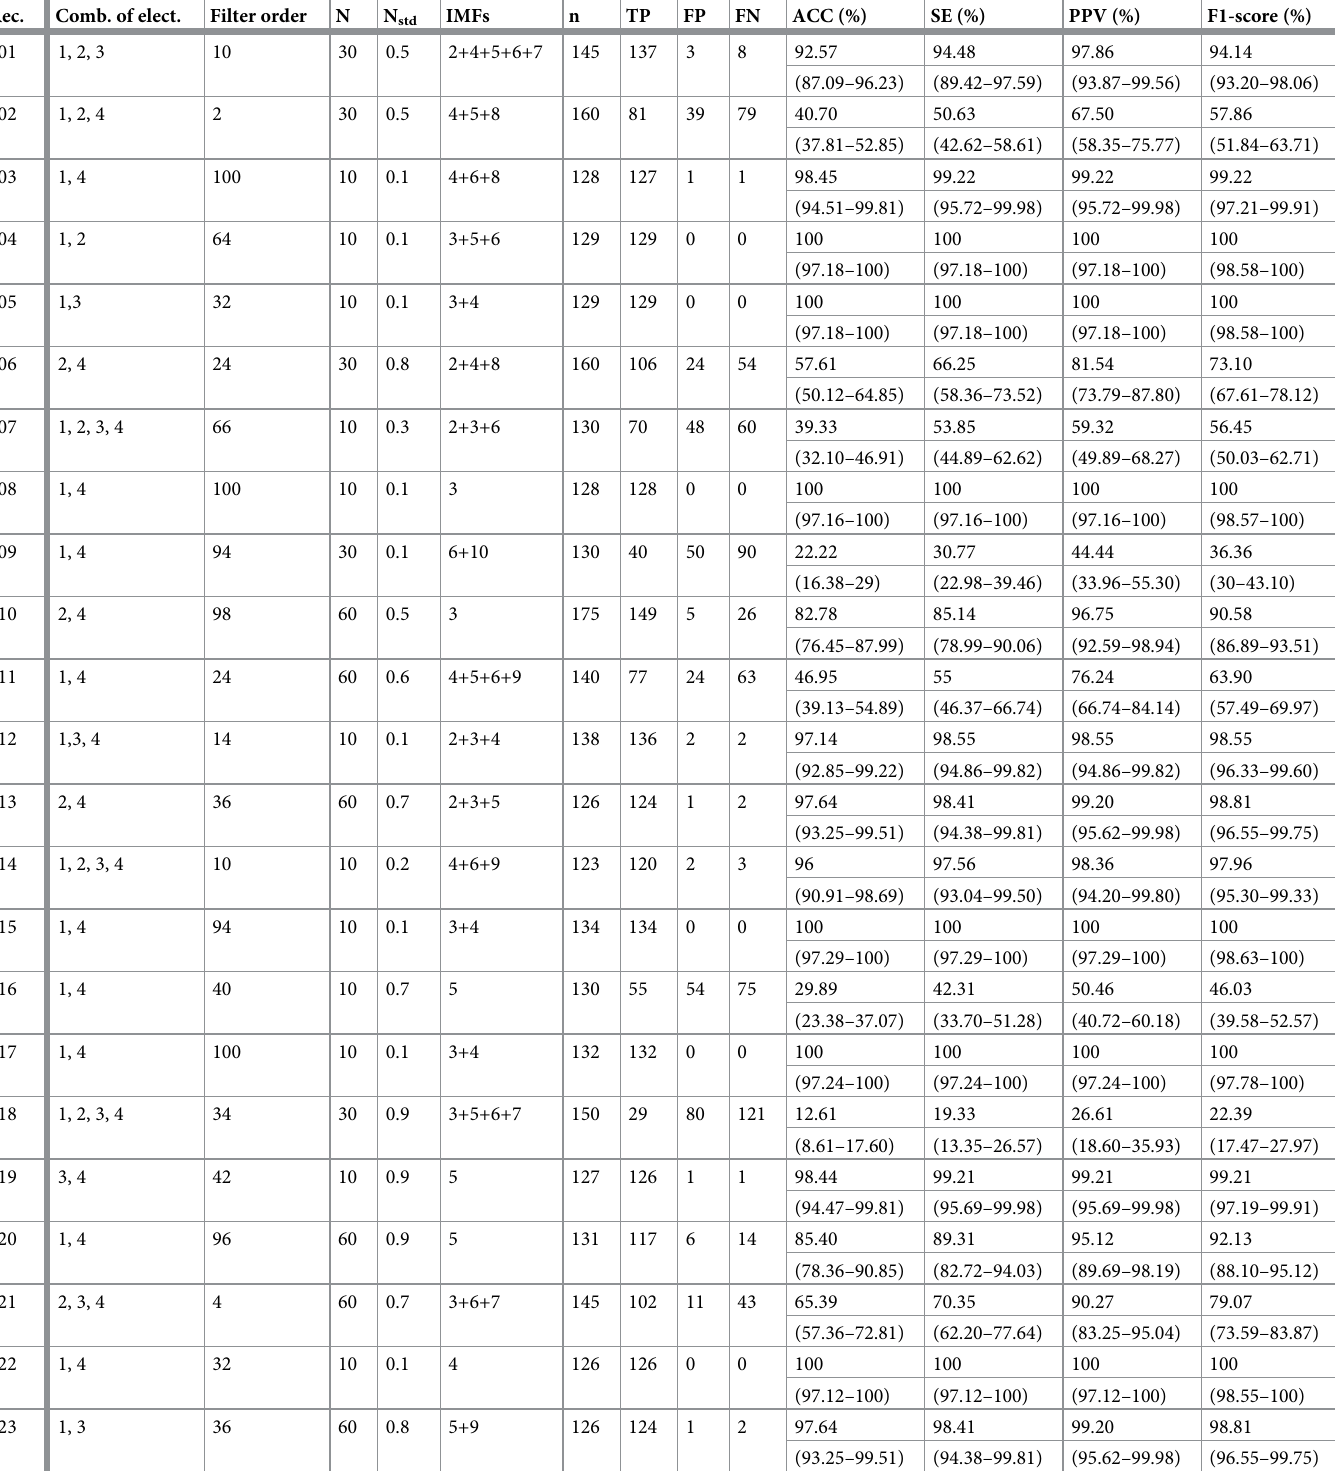
Table 2. Statistical evaluation of the fQRS complexes detection obtained by using the ICA-RLS-EEMD method and the Challenge database (the 95% confidence interval is reported in parenthesis).